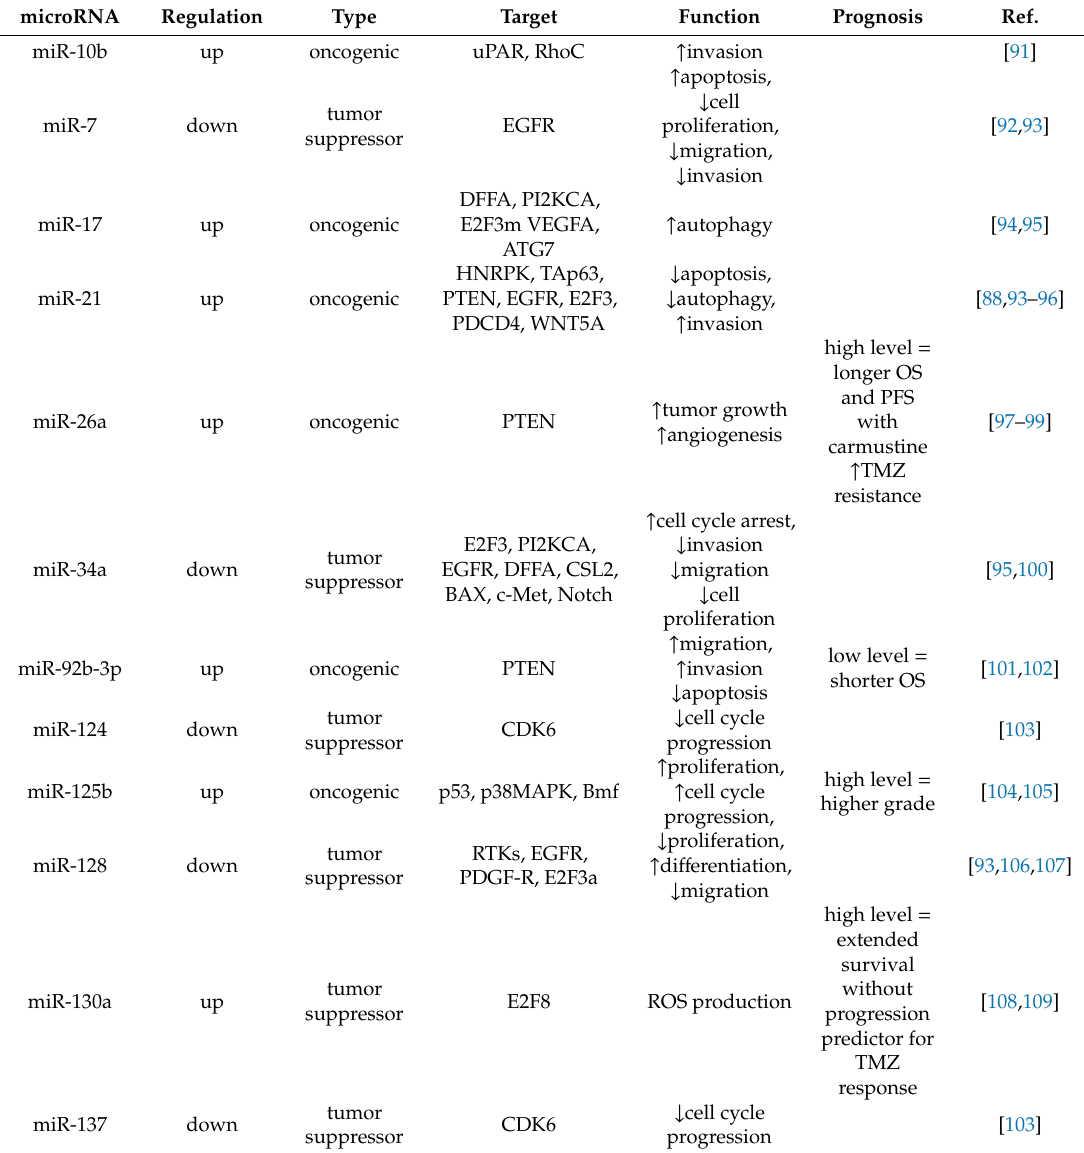
miRNAs in Glioblastoma multiforme, their targets, function, and prognostic value ( ↓ = decreased, ↑ = increased)